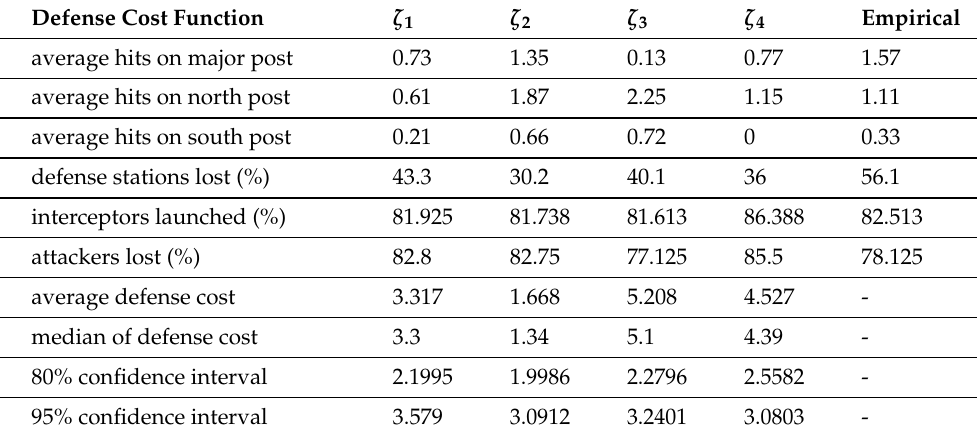
Table 4. Statistics of loss against slant attack